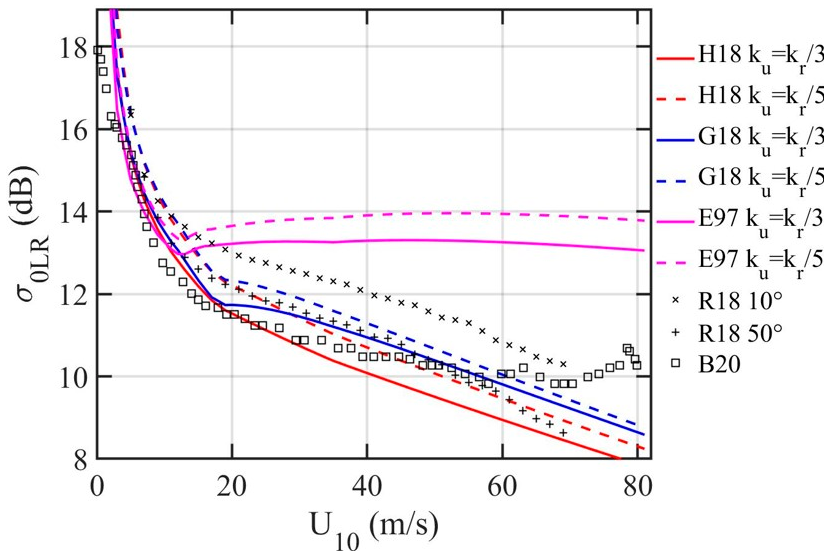
Figure 6. NRCS computed with LPMSSs derived from E97, G18, and H18 spectrum models, and comparison with the CYGNSS NRCS observations: R18 and B20.